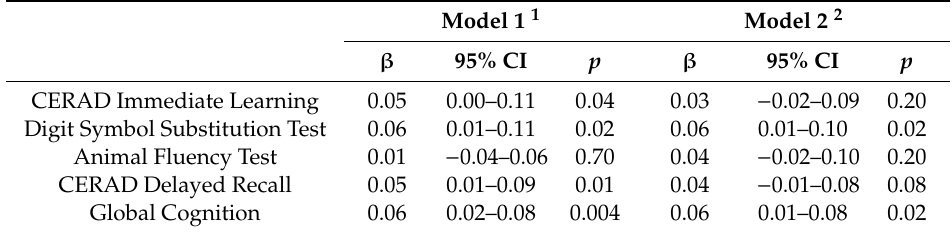
Table 4. Survey weight adjusted ordinary least squares regression models assessing the relationship between continuous MedD scores and education-dependent, standardized cognition scores. ( n = 3068).